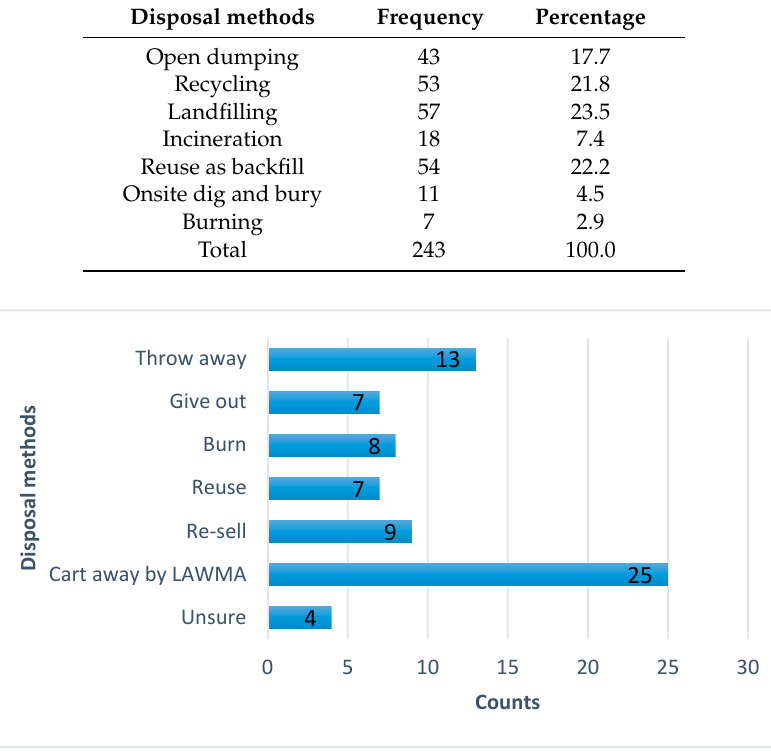
Figure 2. Disposal methods, as indicated by the interviewees.